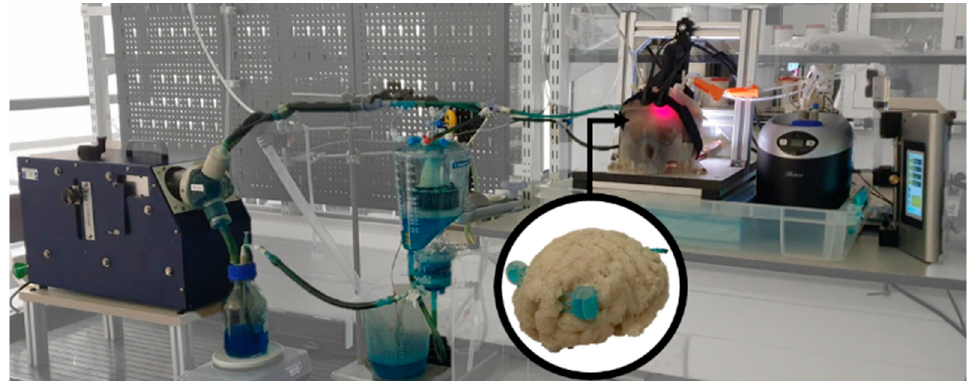
Table 2. Quality evaluation setup parameters.